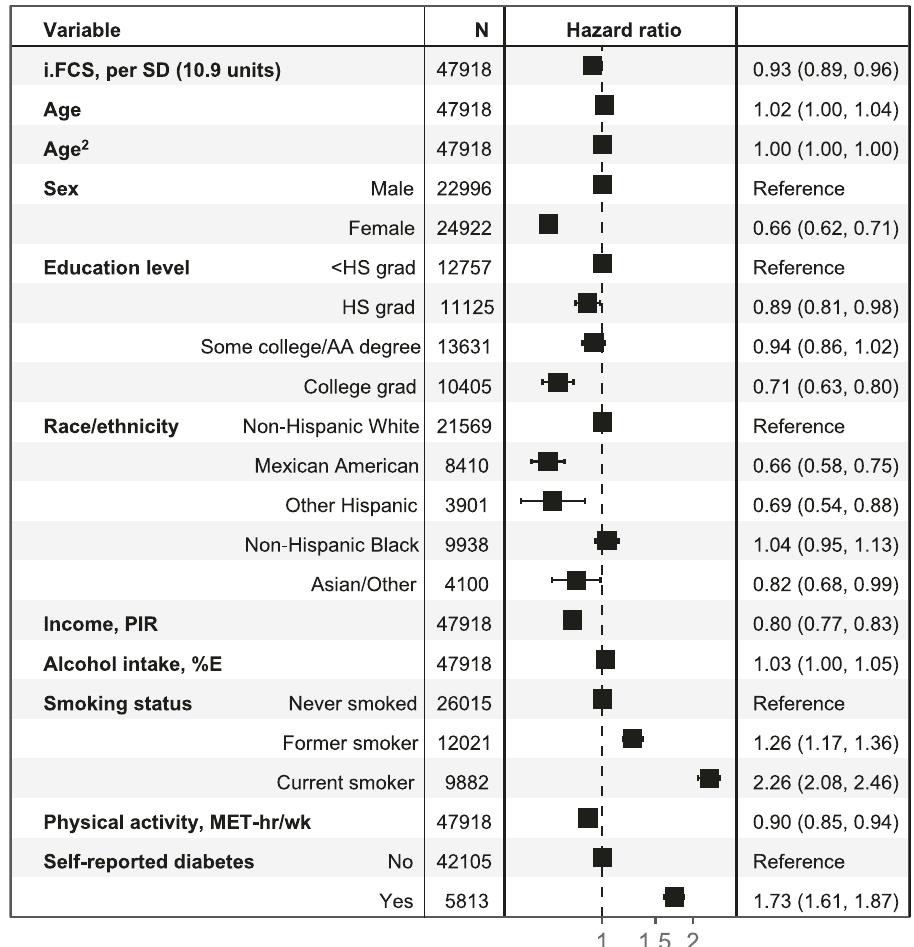
Fig. 4 | Prospective associations of the individual Food Compass Score (i.FCS), sociodemographic factors, and other factors with all-cause mortality among U.S. adults, 1999 – 2018. The i.FCS for each person was calculated as the energy- weighted mean of the FCS of all unique foods and beverages consumed, based on up to two 24hr recalls per person, with a potential range from 1 to 100. Boxes representthemultivariable-adjustedhazardratio;anderrorbars,the95%CI;based on survey-weighted Cox proportional hazard models incorporating NHANES